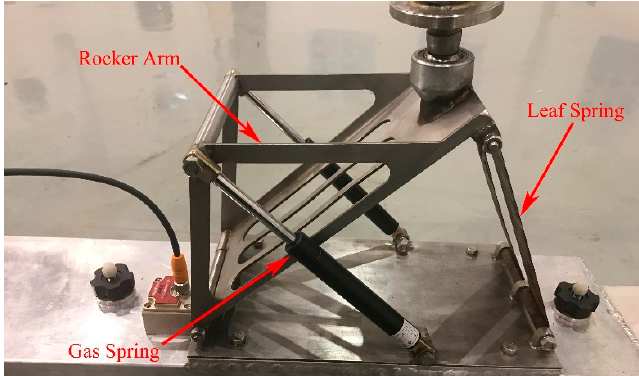
Figure 2. Structure of the suspension system.